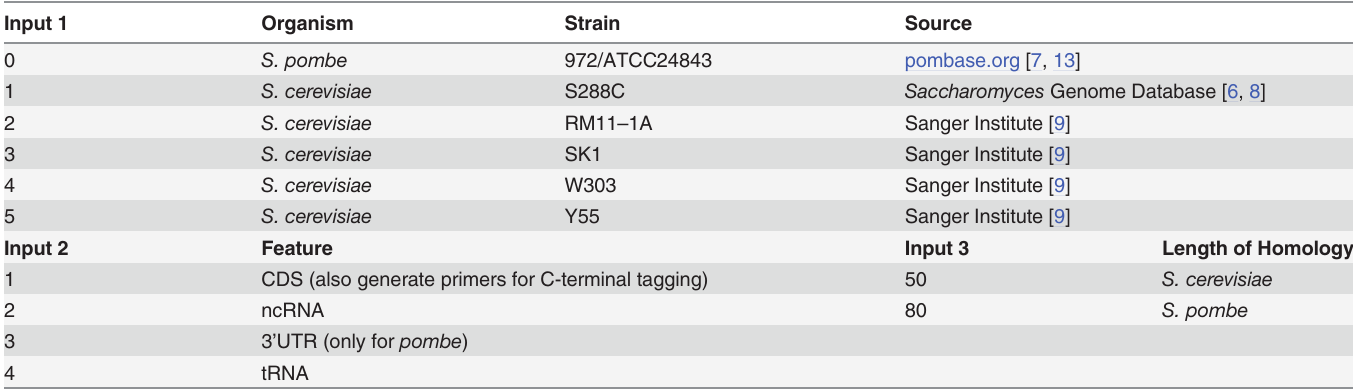
Table 1. List of yeast strains in the database and their sources for genome and annotation fi les, as well as their command line inputs. Input